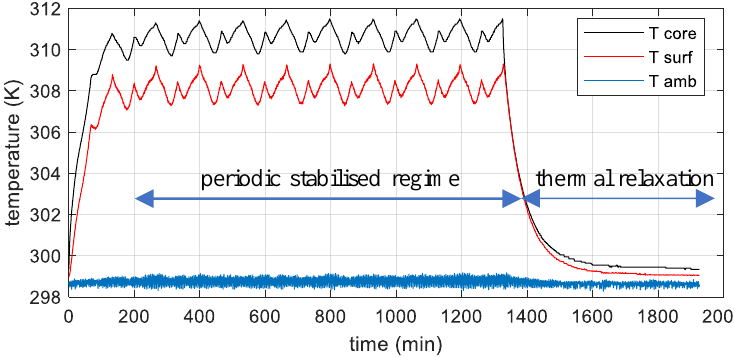
Figure 6. Thermal characterisation test temperature profiles.